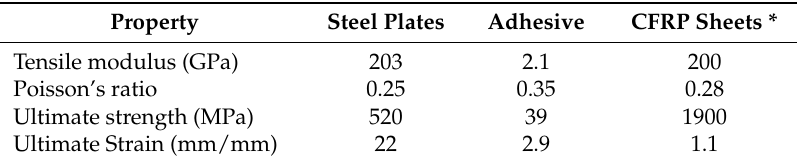
Table 1. Mechanical properties of materials used for experiments.